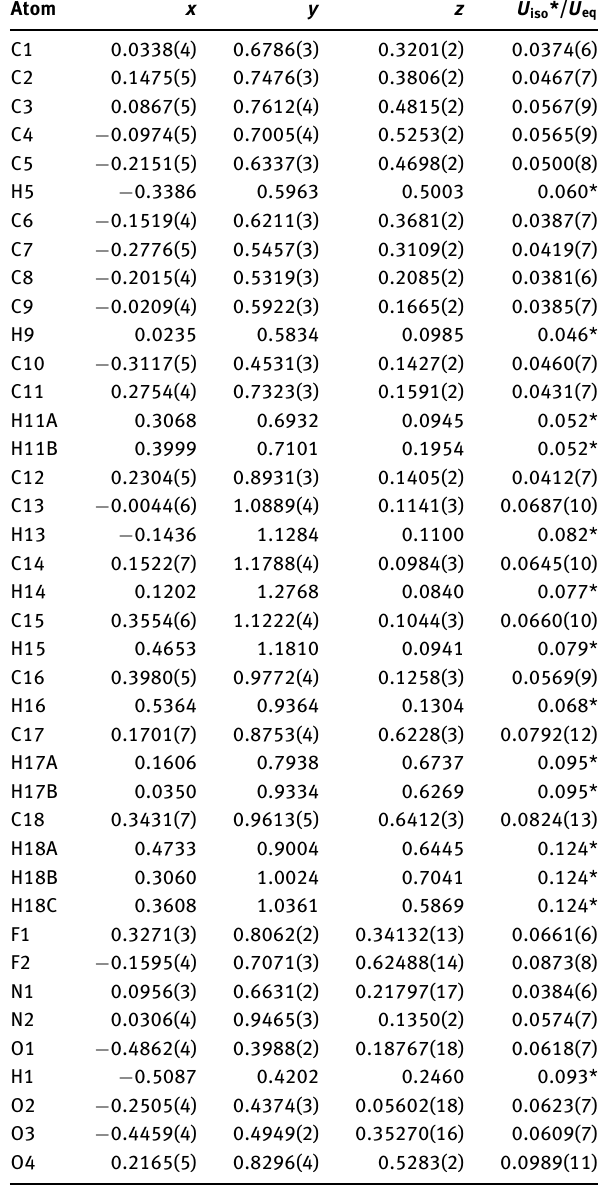
Table 2: Fractional atomic coordinates and isotropic or equivalent isotropic displacement parameters (Å 2